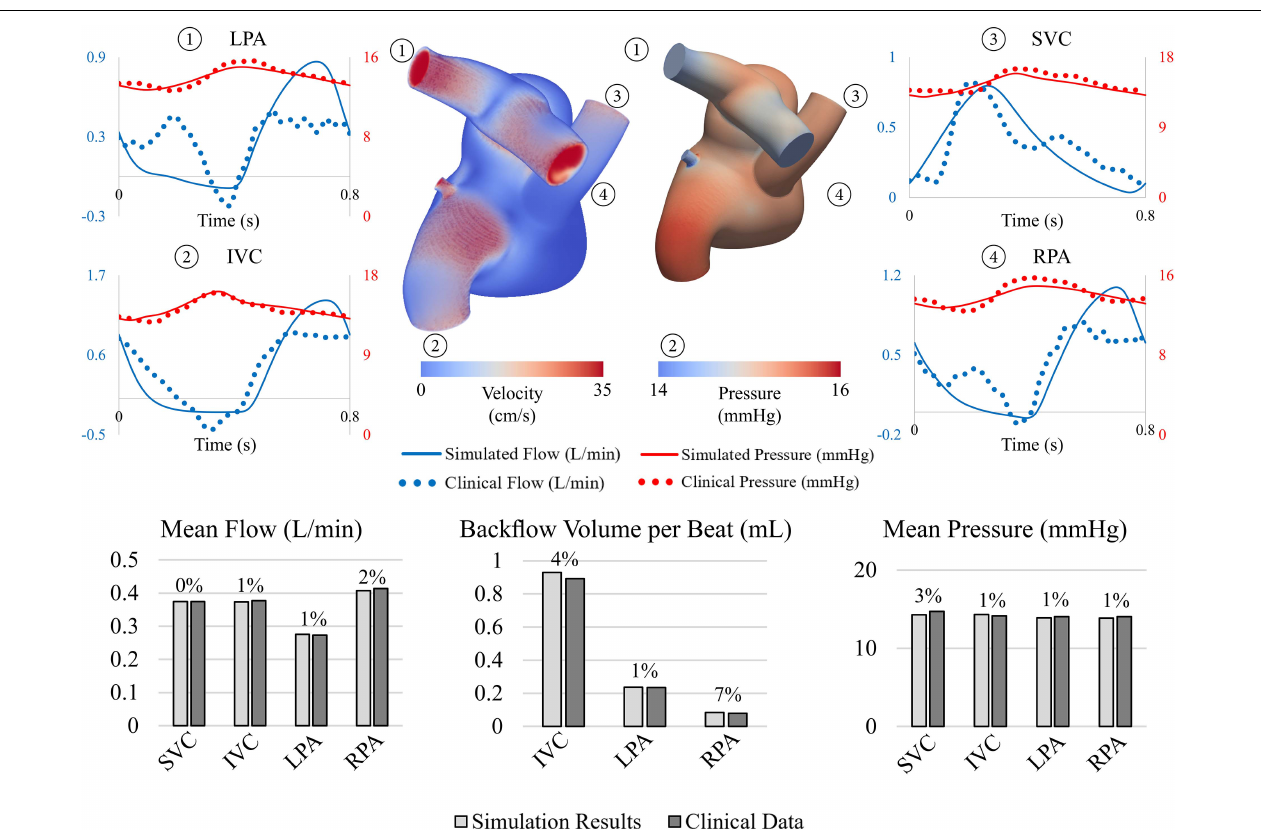
FIGURE 5 | (Top) Velocity volume rendering and pressure contour at end systole. Comparison between flow and pressure waveforms at the LPA, IVC, SVC, and RPA show good agreement. (Bottom) Comparison between simulated results (light gray) and clinical data (dark gray).